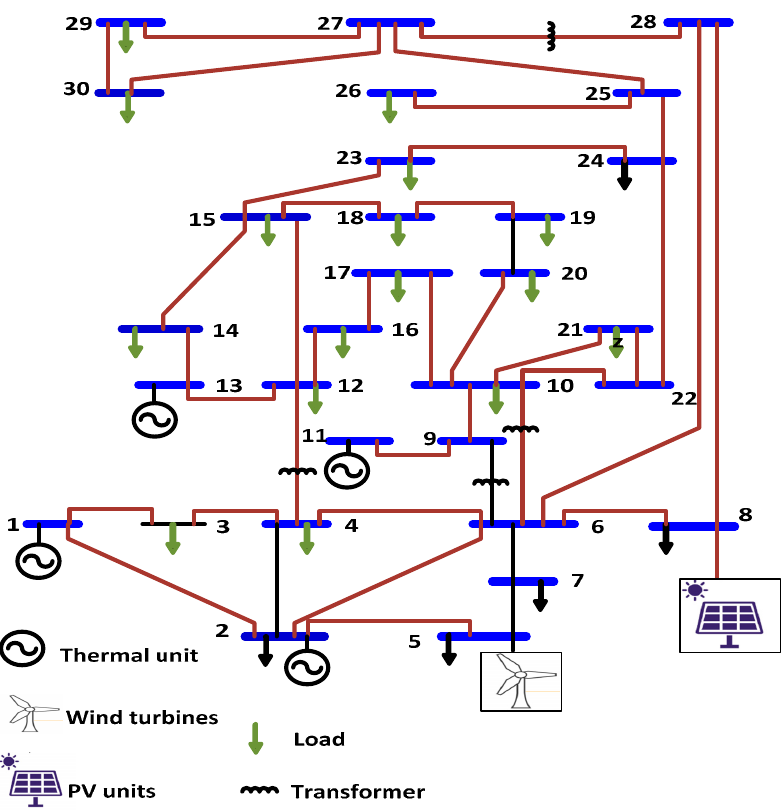
Figure 5. The modified single line diagram IEEE 30-bus system with incorporating a wind generator and a photovoltaic (PV) unit for stochastic optimal reactive power dispatch (ORPD) study.